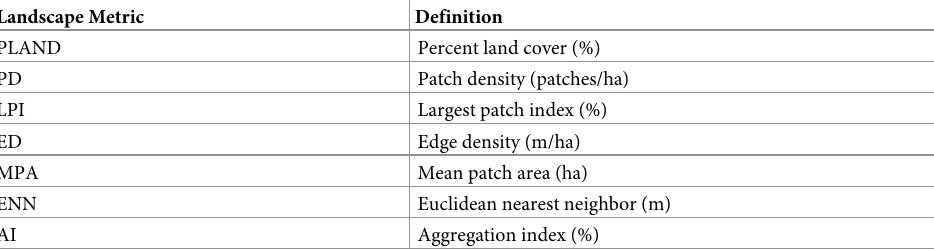
Table 1. Definitions of class-level landscape metrics used in analysis of landscape spatial structure of 26 ocelot- vehicle collision sites and 56 crossing structures in South